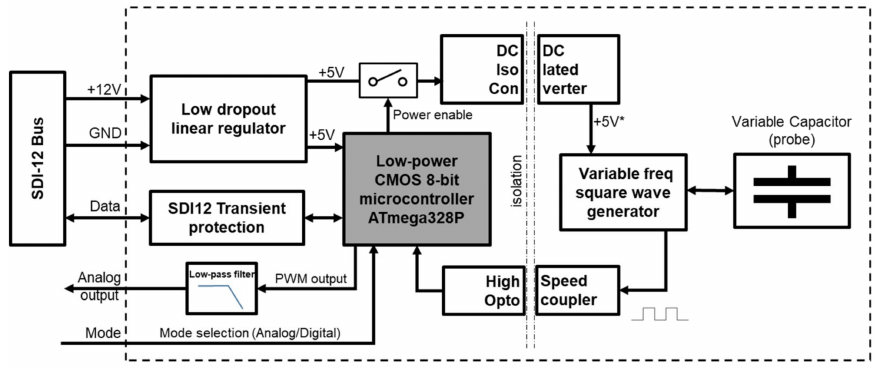
Figure 1. Block diagram.